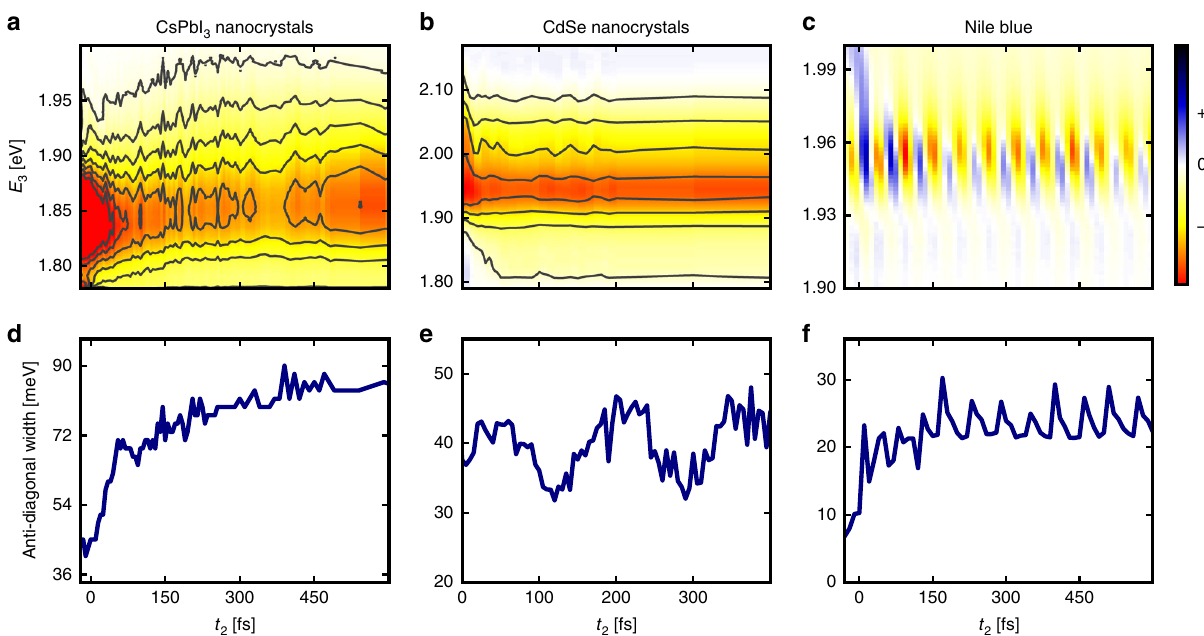
Fig. 3 Comparative analysis shows liquid-like behavior of the perovskite nanocrystals. a – c Pseudo-TA projections obtained by selecting a value of E 1 (narrow pump) on the 2D spectrum and reporting the spectral projections as a function of E 3 (broadband probe). The CsPbI 3 nanocrystals ʼ pseudo-TA map ( a ) is shown for E 1 = 1.82 eV. The CdSe nanocrystals ʼ ( b ) and Nile Blue ( c ) pseudo-TA maps are both shown for E 1 = 1.95 eV. d – f Extracted anti-diagonal linewidth from the 2D spectra shown as a function of t 2 for CsPbI 3 ( d ), CdSe ( e ), and Nile Blue ( f )